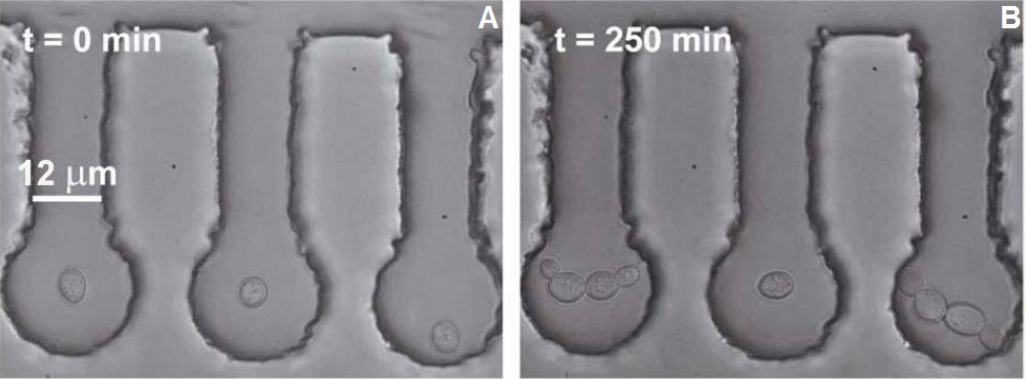
Figure 3. Dynamics of division of Saccharomyces cerevisiae cells stressed by optical tweezers in a microfluidic chip. The cell in the middle micro-chamber was optically trapped with laser power high enough to halt the division, while the two peripheral control cells continue budding. Part ( A ) shows the beginning of the experiment; Part ( B ) demonstrates repeated budding of the peripheral cells 250 min later.